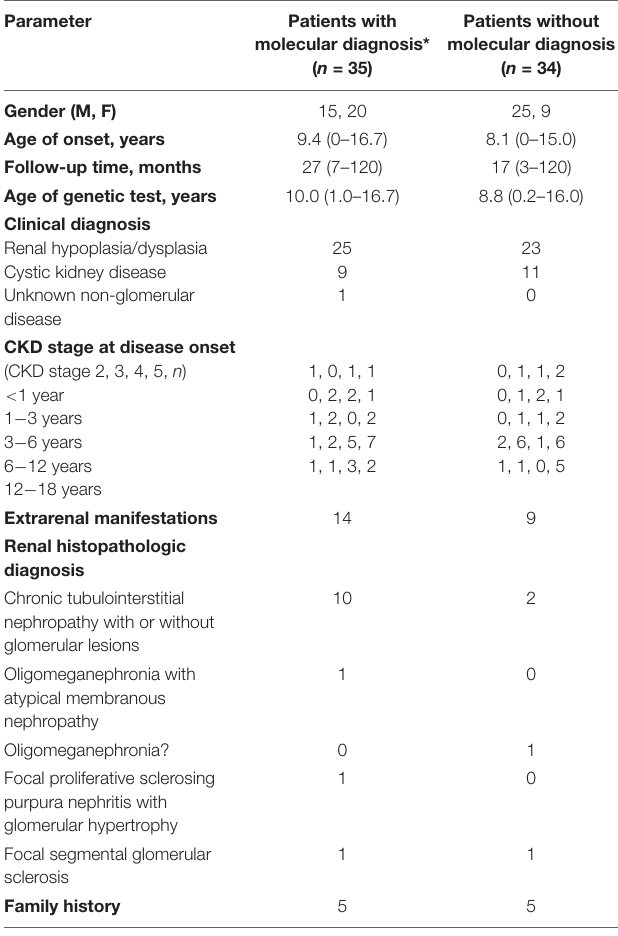
TABLE 1 | Clinical features of the 69 patients from the present